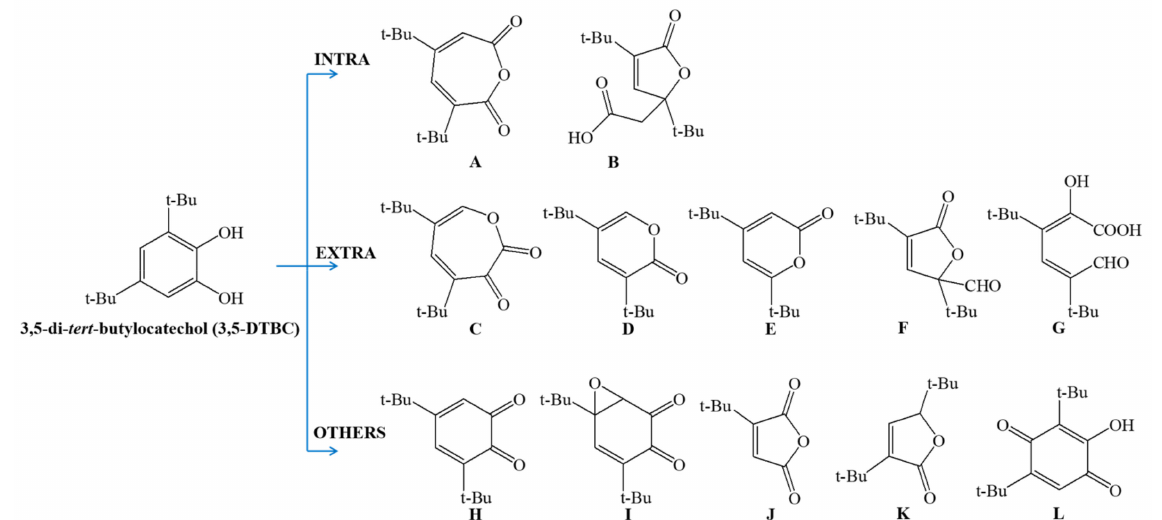
Figure 6. Products of catechol oxidation in 3,5-DTBC: 3,5-di- tert -butyl-1-oxacyclohepta-3,5-diene-2,7-dione ( A ), 3,5-di- tert -butyl-5-(carboxymethyl)-2-furanone ( B ), 4,6-di- tert -butyl-1-oxacyclohepta-4,6-diene-2,3-dione ( C ), 3,5-di- tert -butyl- 2H-pyran-2-one ( D ), 4,6-di- tert -butyl-2H-pyran-2-one ( E ), 3,5-di- tert -butyl-5-(formyl)-2-furanone ( F ), cis,cis-3,5-di- tert - butyl-2-hydroxy-muconic semialdehyde ( G ), 3,5-di- tert -butyl-1,2-benzoquinone ( H ), 3,4-epoxy-3,4-dihydro-4,6-di- tert -butyl- 1,2-benzoquinone ( I ) 3- tert -butylfuran-2,5-dione ( J ), 3,5-di- tert -butylfuran-2(5H)-one ( K ), 3,5-di- tert -butyl-2-hydroxy-1,4- benzoquinone ( L